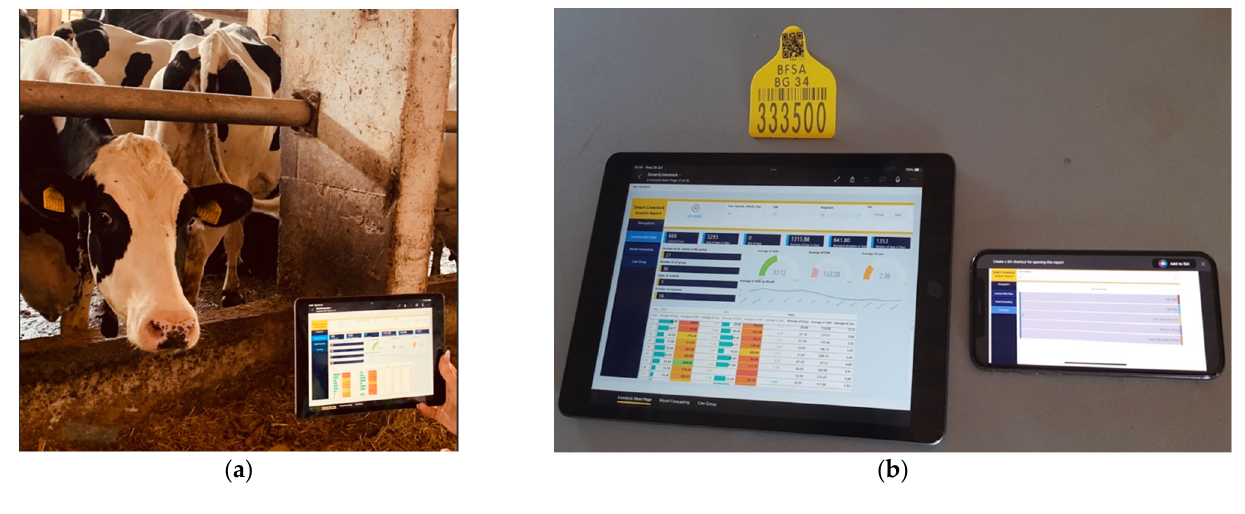
Figure 18. ( a ) Scanned ear tag with lasered QR code—testing in a real environment, and ( b ) scanned QR tag by different devices.